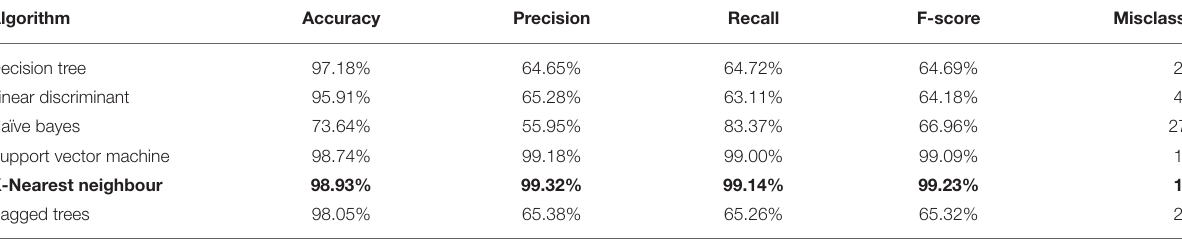
TABLE 11 | Corrective maintenance performance evaluation. Algorithm